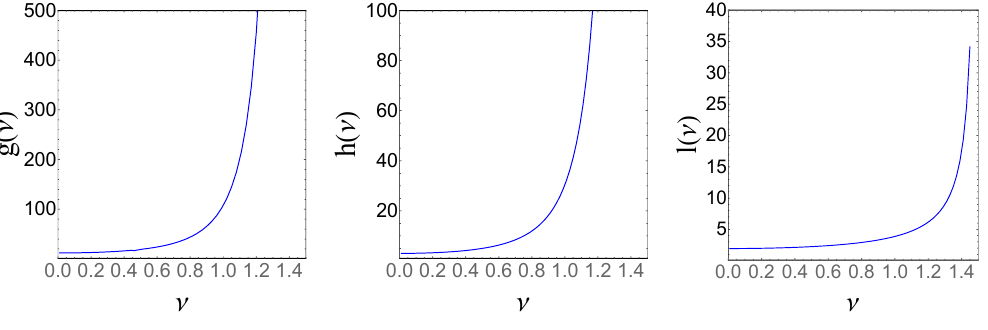
Figure 1 . Numerical values of g ( ν ) , h ( ν ) , and l ( ν )